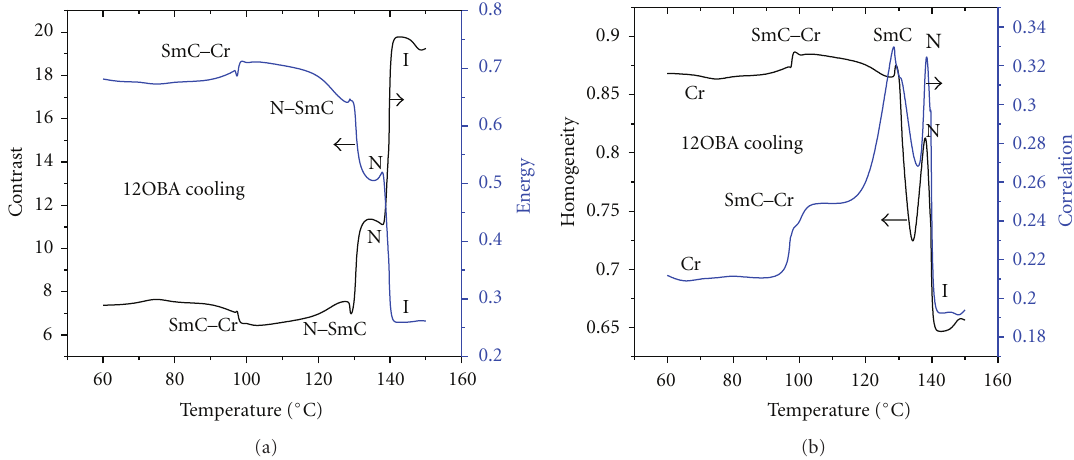
Figure 9: Computed parameters from the textures of 12OBA as a function of temperature where the phase transitions are indicated. (a) Contrast and energy; (b) homogeneity and correlation. Cr: Crystal, SmC: SmecticC, N: Nematic, I: